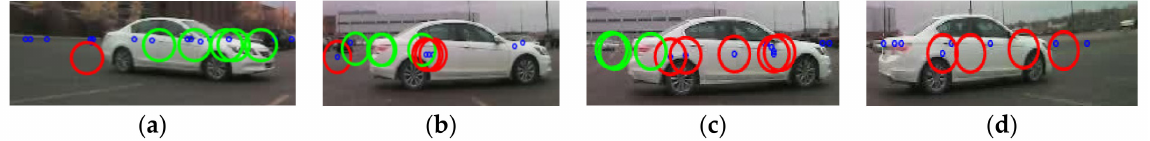
Figure 16. Tracking robustness by two radar sensors: ( a ) the left radar (more green circles than the red circles) mostly captures the object; ( b , c ) the signals from the left and right radar sensors detect the object; ( d ) only signals from the right radar are captured the